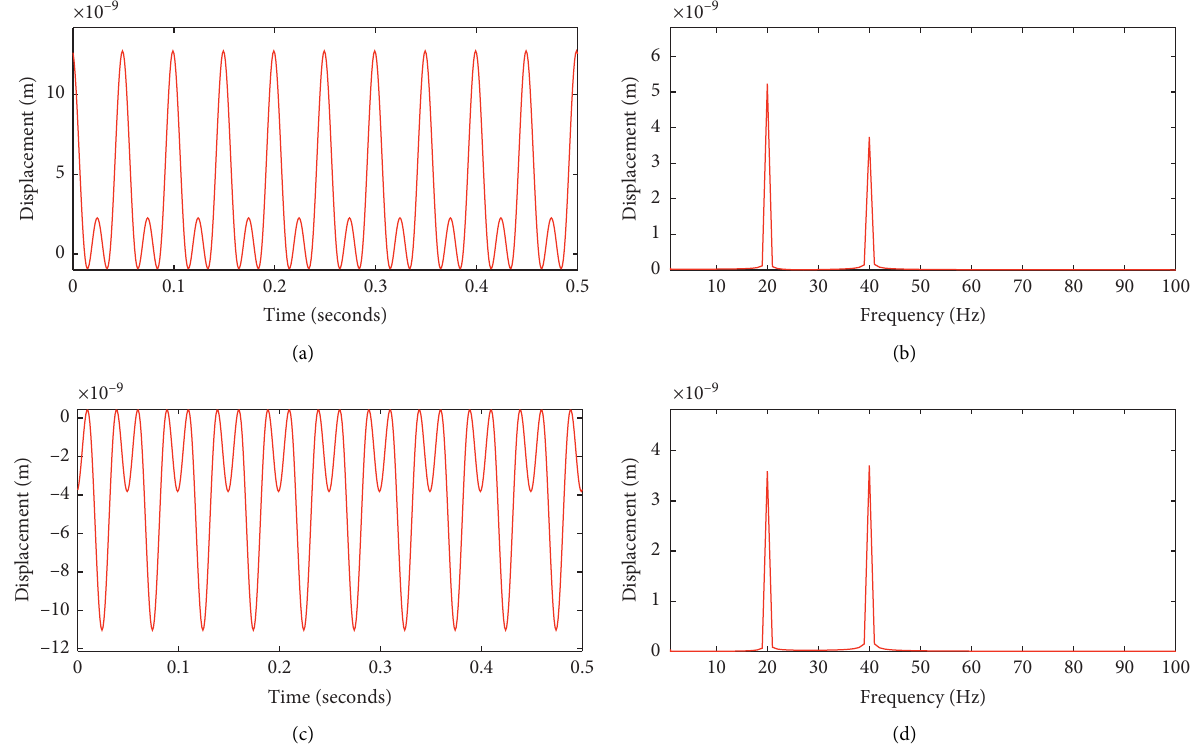
Figure 15: Time- and frequency-domain responses in the radial directions y misalignment. (a) Time response of y1. (b) Frequency response of y1. (c) Time response of y2. (d) Frequency response of